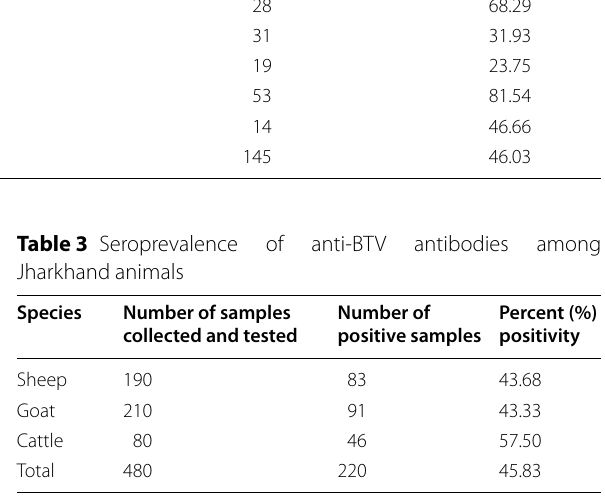
Table 2 Seroprevalence of anti-BTV antibodies among Bihar animals Animal species Sheep